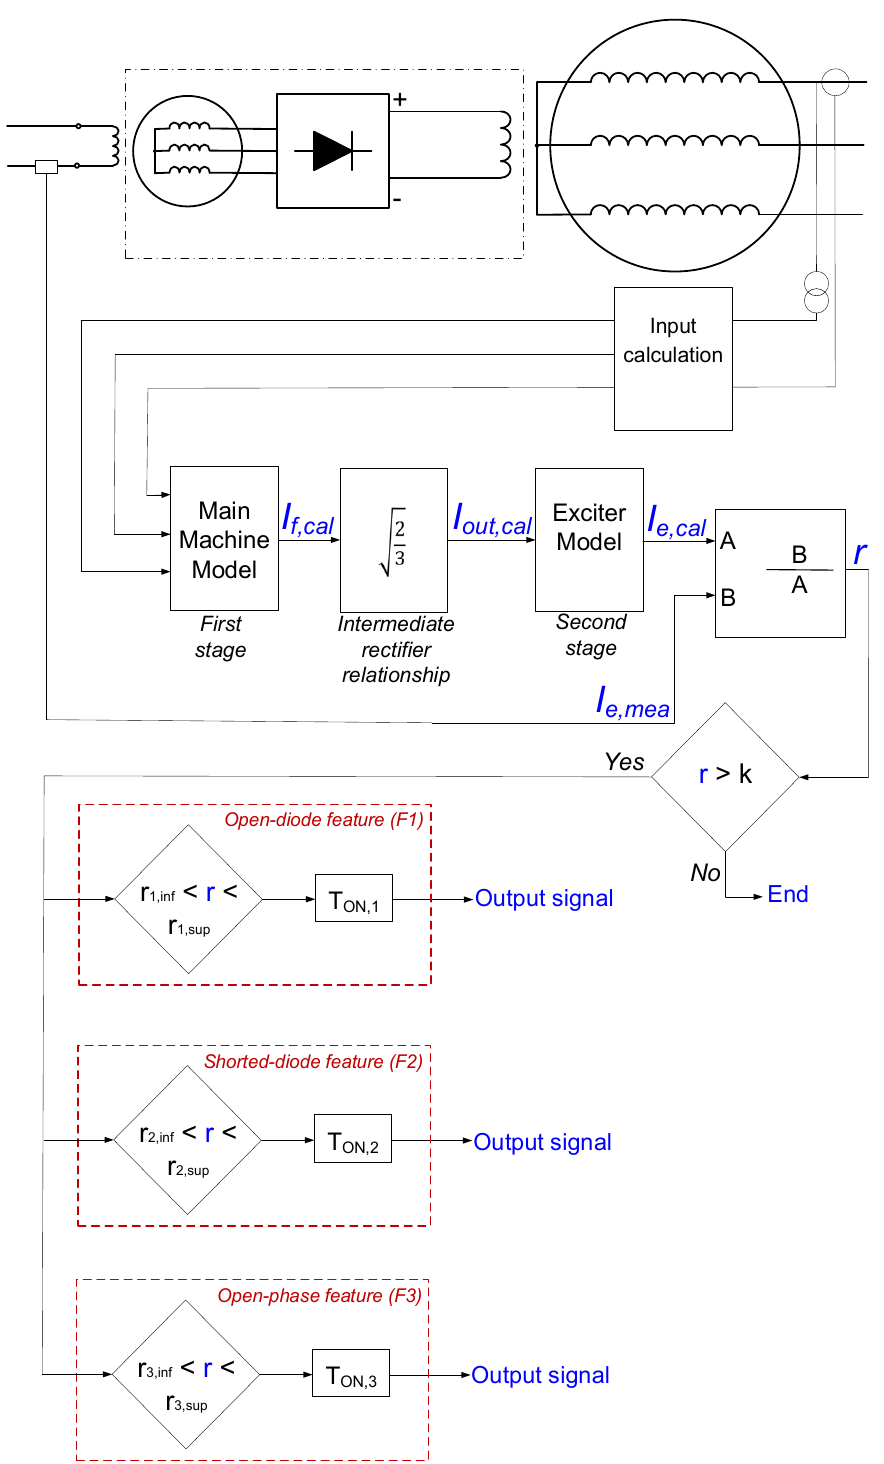
Figure 3. Simplified schema of the fault detection method and protection features.